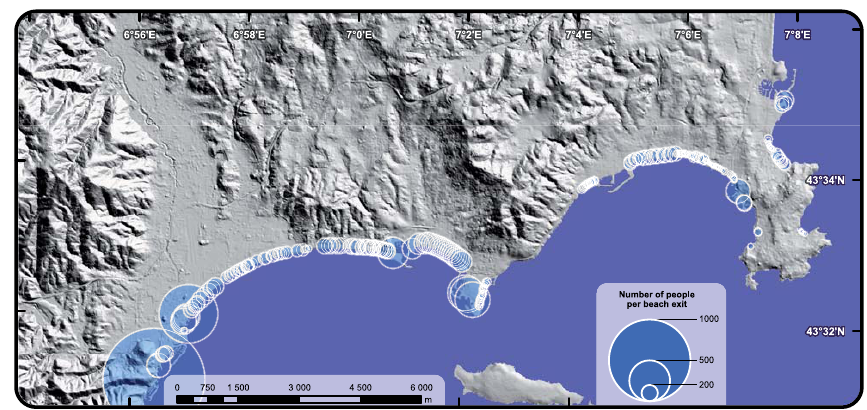
Fig. 4. People per beach exit that would need to be evacuated.